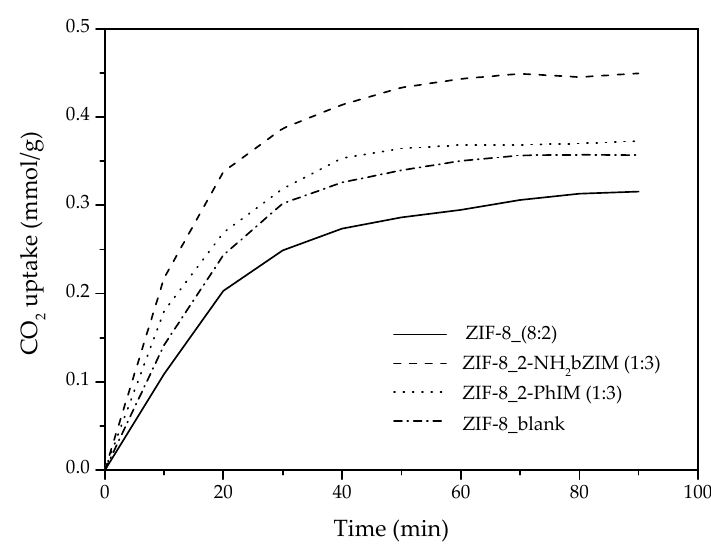
Figure 16. Comparison of CO 2 uptake of synthesized ZIF-8 by water based synthesis with hydrogen bond acceptor assisted and exchanged ZIF-8 at 313 K.